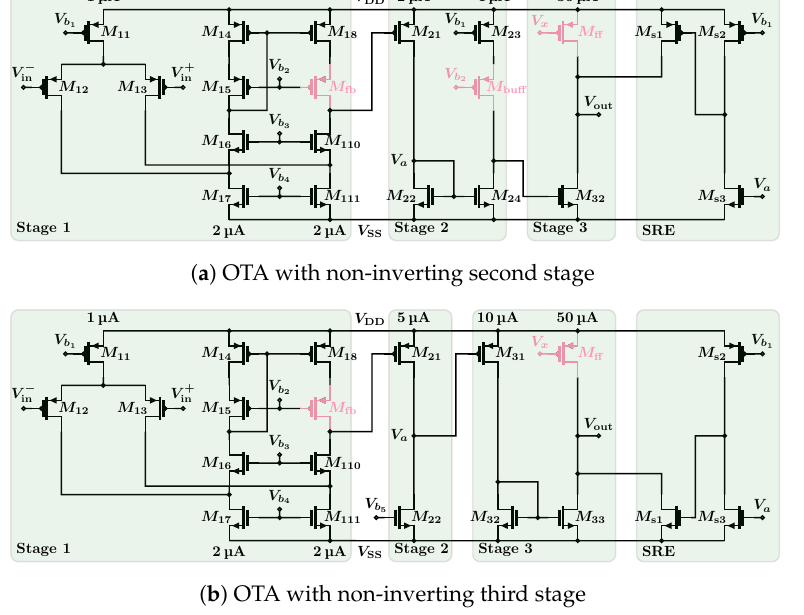
Figure 12. Schematic diagrams for the two OTA cores used in simulations. Magenta transistors indicate auxiliary transconductance elements used for compensation. M buff in ( a ) is used as a current buffer in TCFC only and is removed in other